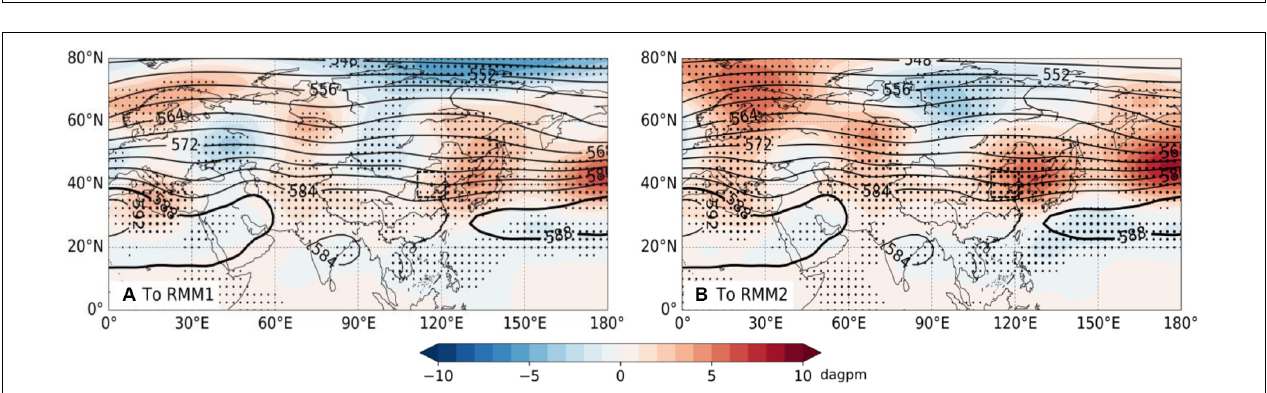
FIGURE 8 | Composites of 500-hPa height (contour line) and its anomalous (the dotted areas exceed 95% confidence level) in each phase of MJO in the summer of 2018. Unit: dagpm. (A) The composite map of 500hPa height field (isoline) and its anomaly (shaded areas, doted areas passed the 95% confidence level) corresponding to the phase 1-2 of MJO. (B–D) The same, but corresponding to the 3-4, 5-6, 7-8 phases of MJO.